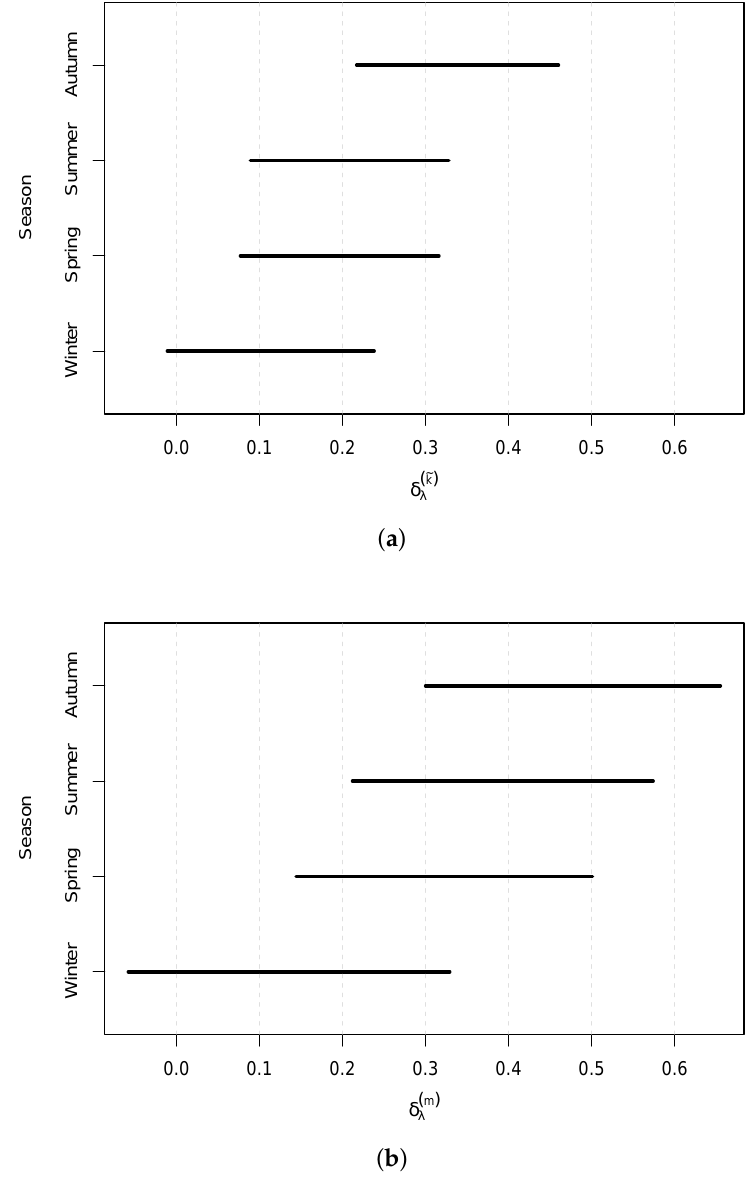
( ˜ k ) ( m ) and ( b ) ˆ δ at Newlyn for s = 1,2,3,4 λ , s λ , s